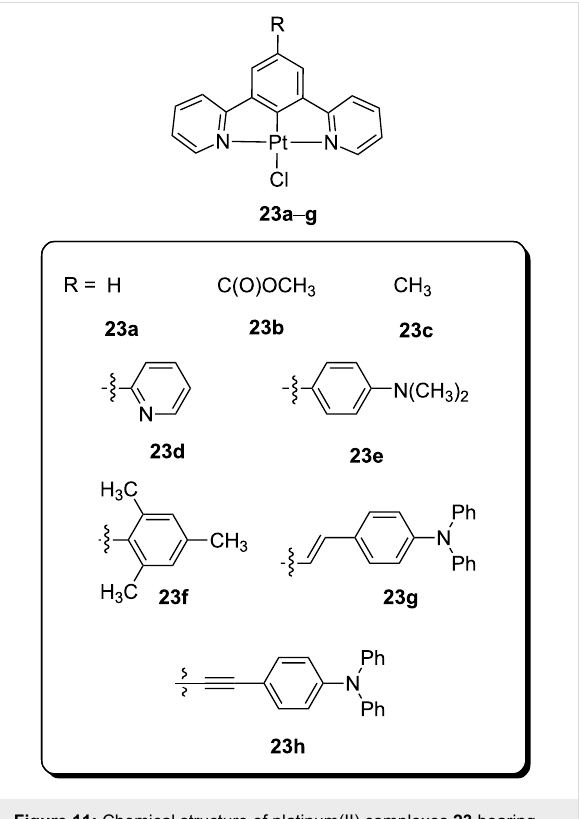
Figure 11: Chemical structure of platinum(II) complexes 23 bearing bis -cyclometalating 2,6-dipyridylbenzene type of ligands